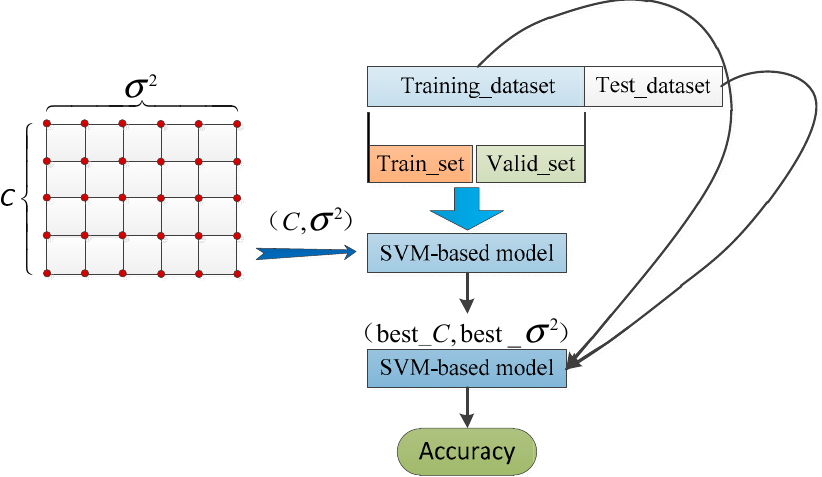
Figure 5. Parameter optimization of SVM for fault diagnosis of PMDCMs.